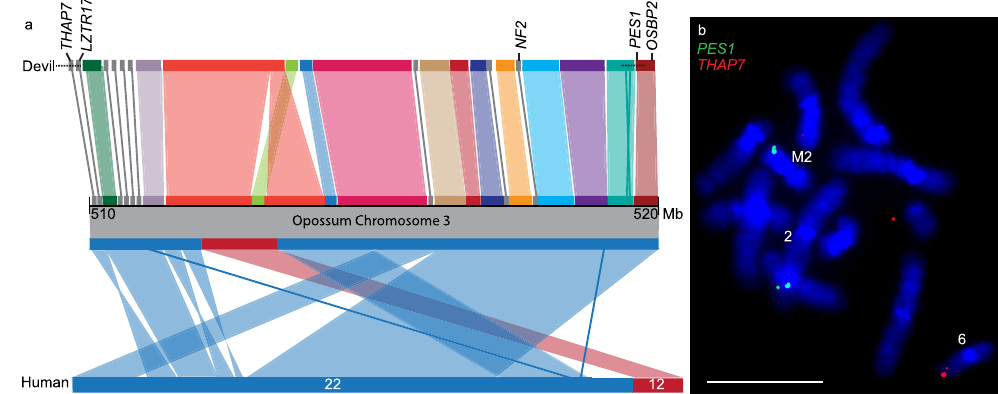
Figure 4. The NF2 region ( a ) Comparison of the 10 Mb region surrounding NF2 on opossum chromosome 3 (position 510–520 Mb) with devil reference genome scaffolds (each scaffold is a different colour) and human chromosomes 22 (blue) and 12 (red). The order of the devil scaffolds is unknown, although BAC end sequences join several scaffolds indicated by a dotted line. ( b ) Rearrangement detected in the NF2 region in DFT1. PES1 is located on DFT1 derivative chromosome 2 and M2. Only one signal is detected for THAP7/LZTR1 , localising to derivative chromosome 6. Scale bar represents 10 μ